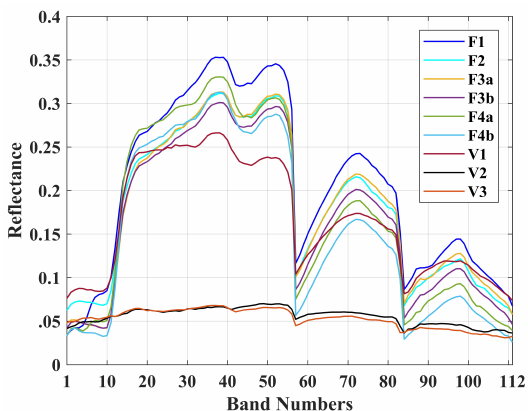
Figure 3. The reflectance spectra of targets in the HyMap dataset.